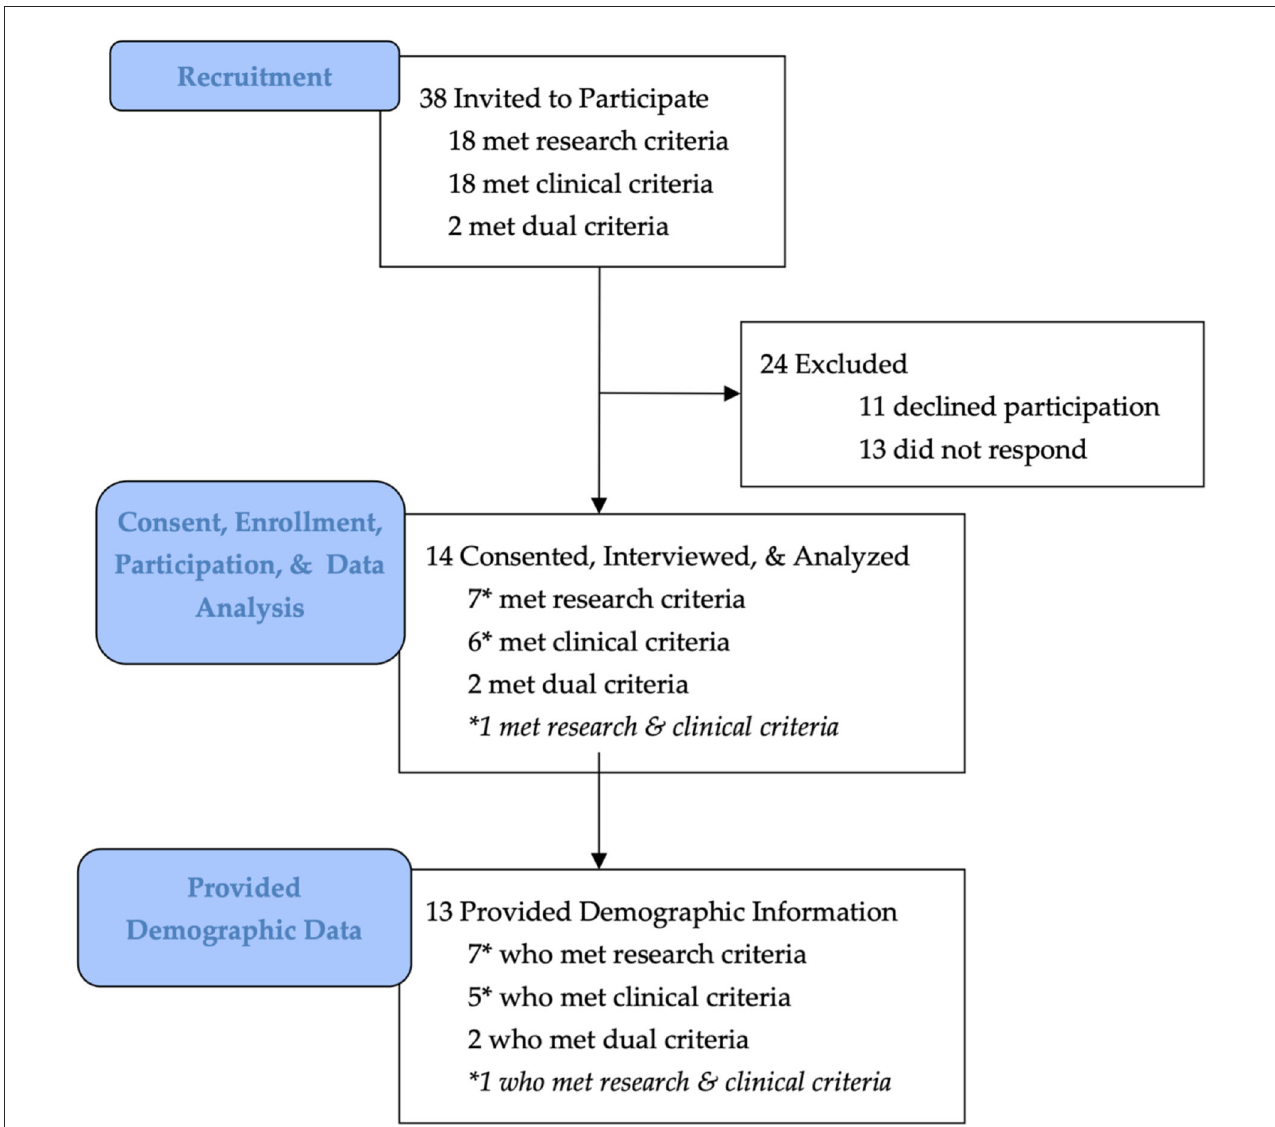
FIGURE1 Diagram of study flow, from participant identification to enrollment and follow-up. Thirty-eight experts met enrollment criteria and were invited to participate in the study. This included 18 experts who met the academic/research criteria (18/38, 47%), 18 experts who met the clinical criteria (18/38, 47%), and two who met the dual criteria (2/38, 5%; Table 1). Fourteen eligible experts consented, enrolled, and participated in the study (14/38, 37%), including six individuals who met the academic/research criteria (6/14, 43%), five who met the clinical criteria (5/14, 36%), one who met both the academic/research and clinical criteria (1/14, 7%), and two who met the dual criteria option (2/14, 14%) (Table 3). Thirteen participants (13/14, 93%) provided demographic information and were included in demographic analysis (Table 3). All 14 participant interviews were included in thematic analysis. Reproduced with permission from Bray et. al.,